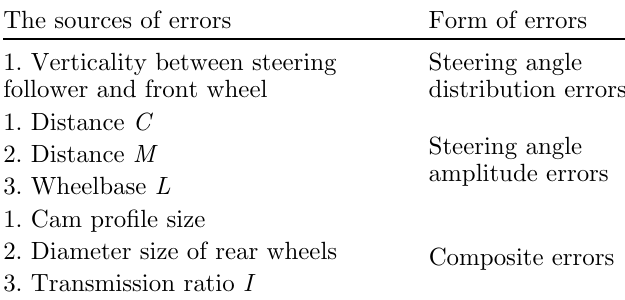
Table 1. Errors classi fi cation.